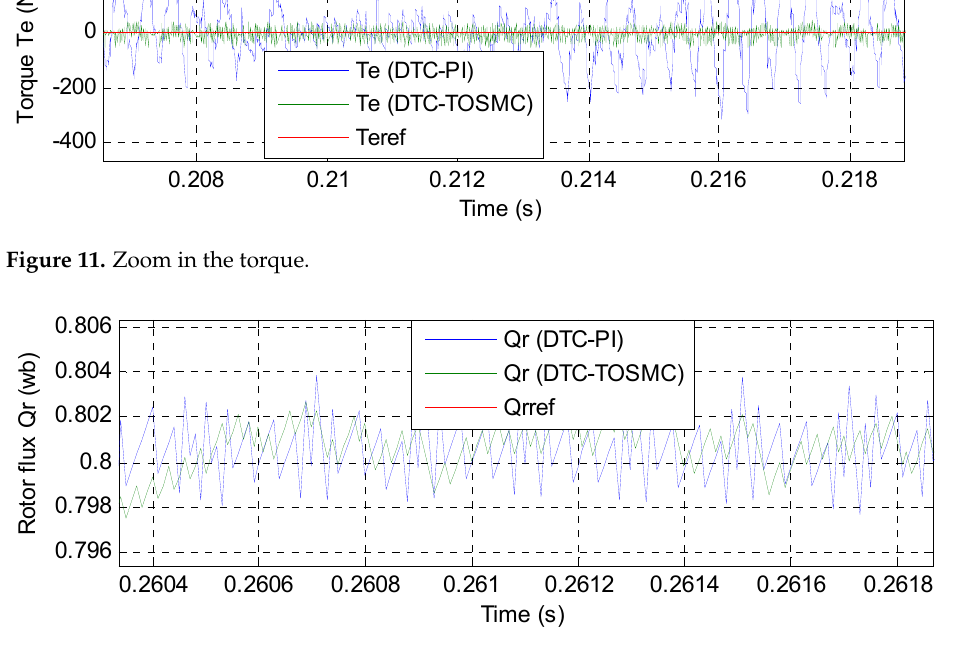
Figure 12. Zoom in the rotor flux.